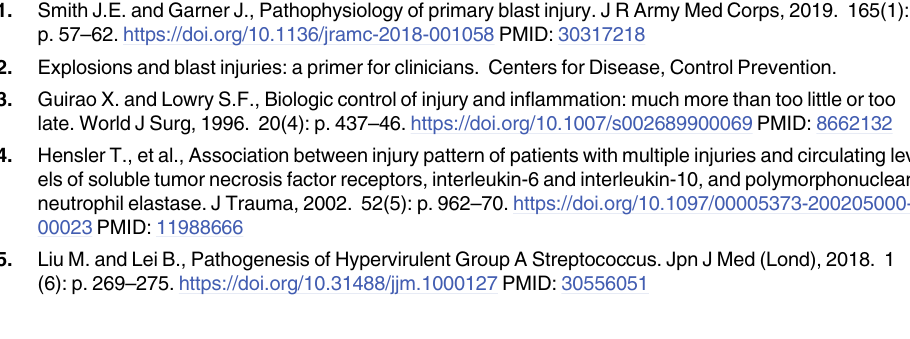
S1 Fig. Timeline of the